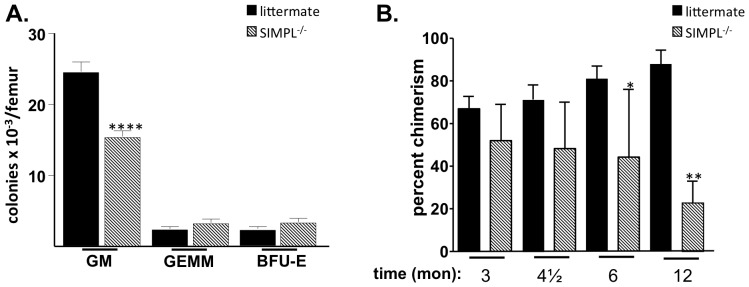
SIMPL is required for steady-state hematopoietic progenitor and stem cell function.(A) Low density bone marrow cells were cultured in triplicate in clonogenic methylcellulose progenitor assays at 1×104 cells/mL. The total number of colony forming units (CFU; CFU-GM; BFU-E or CFU-GEMM) were quantitated 7 days later. A 2-tailed t-test was used to determine statistical significance with individual assays performed in triplicate (n = 9 animals/per strain) (B) Whole bone marrow cells from SIMPL−/− or littermate controls (CD45.2+) were mixed with congenic CD45.1+ competitor marrow cells (1∶1) in a 1∶1 ratio (200,000 cells from each) and transplanted intravenously into lethally irradiated CD45.1+ mice (1100-cGy split dose). The proportion of CD45.1+ and CD45.2+ cells in peripheral blood was determined monthly by flow cytometry. Percent chimerism reflects the proportion of CD45.2+ cells present in the peripheral blood. A 2-tailed t-test was used to determine statistical significance (n = 5 animals/per strain, each assayed individually), ****p<0.0001; **p<0.01; *p<0.05.